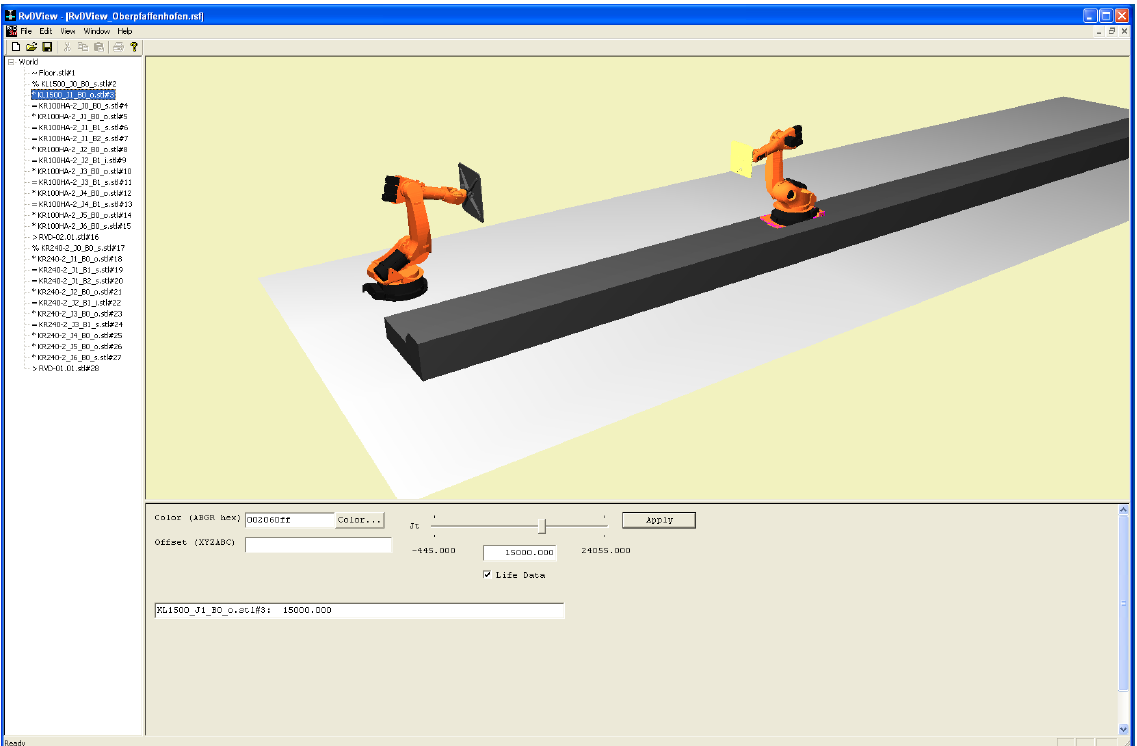
Figure 11: RvD View - Visualization of the motion of the robots.